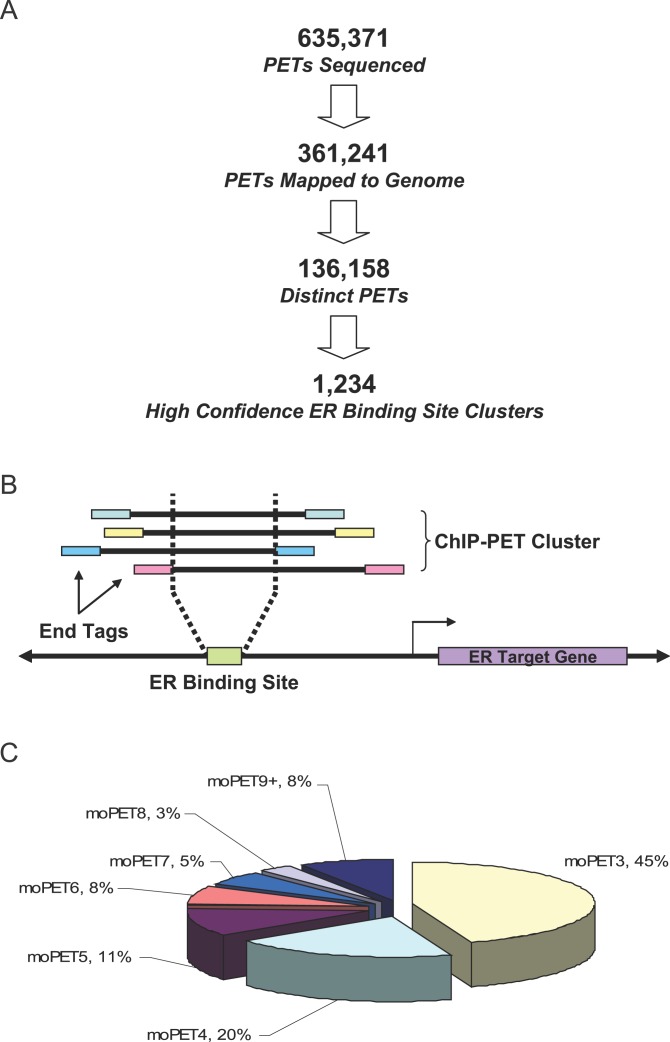
ChIP-PET Analysis Identified 1,234 High Confidence ER Binding Sites in MCF-7 Cells(A) A total of 635,371 PETs were sequenced and resolved into 1,234 binding site clusters after filtering for ambiguous and redundant mapping and local noise in amplified regions of the genome.(B) This diagram illustrates binding site mapping by a cluster of ChIP-PETs. ER binding site is situated in the region of overlap between the ChIP fragments and their PETs.(C) All of the 1,234 high confidence clusters have at least three PETs in their region of overlap (moPET3+) with the largest number of clusters being moPET3s.